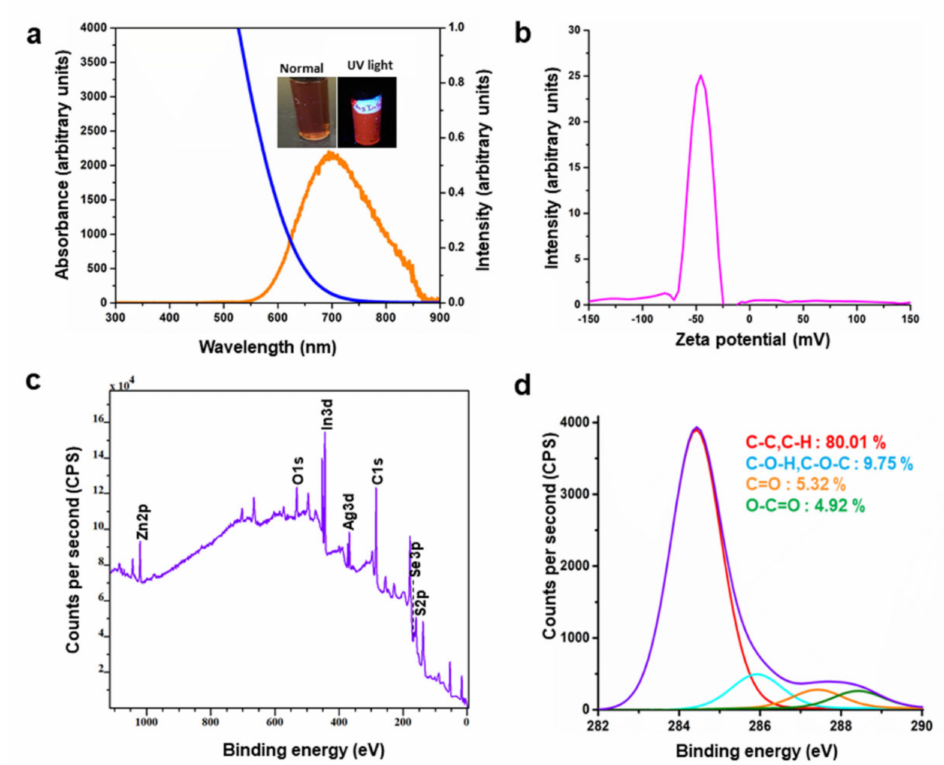
Figure 2. ( a ) Photoluminescence & UV absorption spectra (with images insert under normal and UV light at 365 nm), ( b ) Zeta potential spectra, ( c ) XPS survey spectra, and ( d ) high-resolution C1s spectra of AgInSe/ZnS